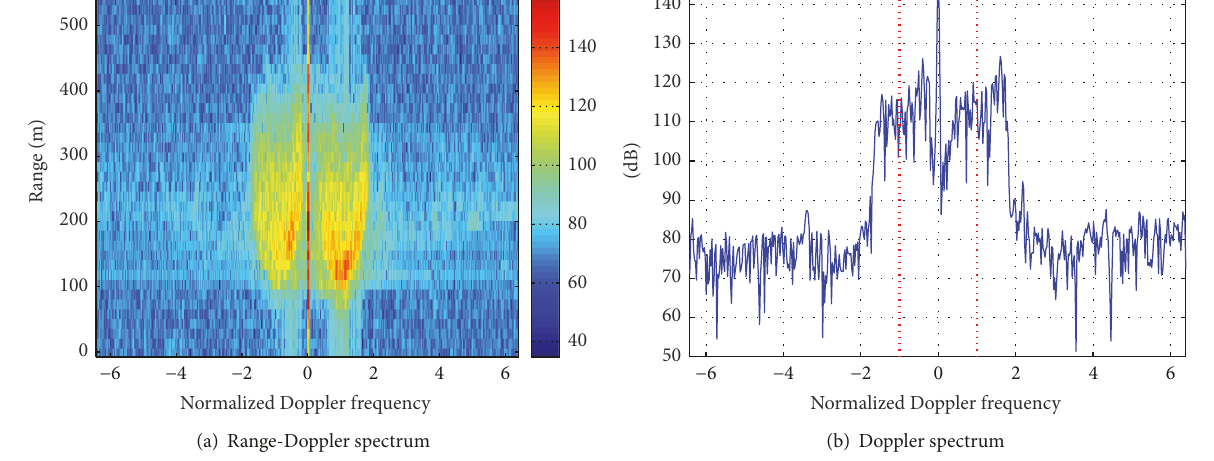
Figure 11: Echo Spectrum.